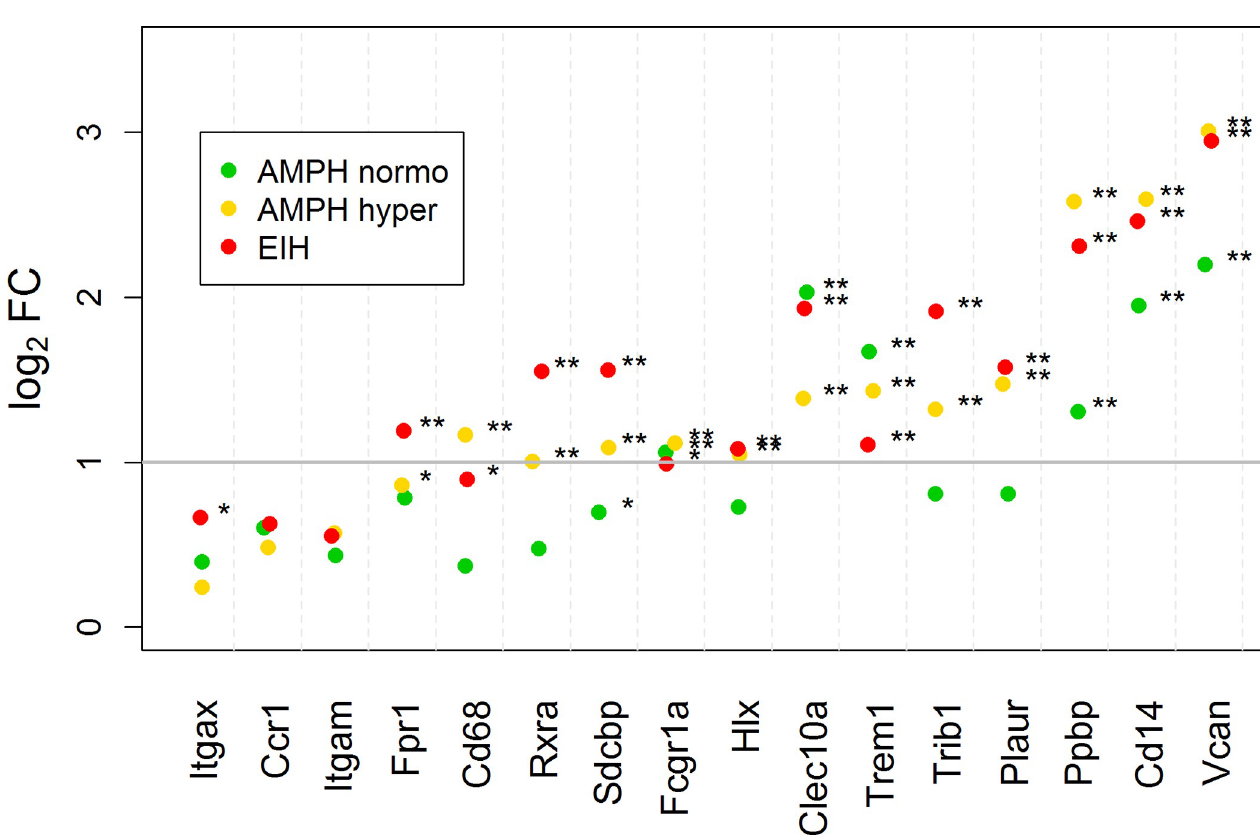
Fig 3. Scatterplot of fold-change expression for monocyte-specific mRNA transcripts in whole blood. The log2 fold-changes for the AMPH normo, AMPH hyper, and EIH groups relative to control are shown. The horizontal gray bar indicates a 2-fold increase in expression compared to control. The subscripts � and �� indicate that the fold-change is significant and exceeds 1.5 and 2,